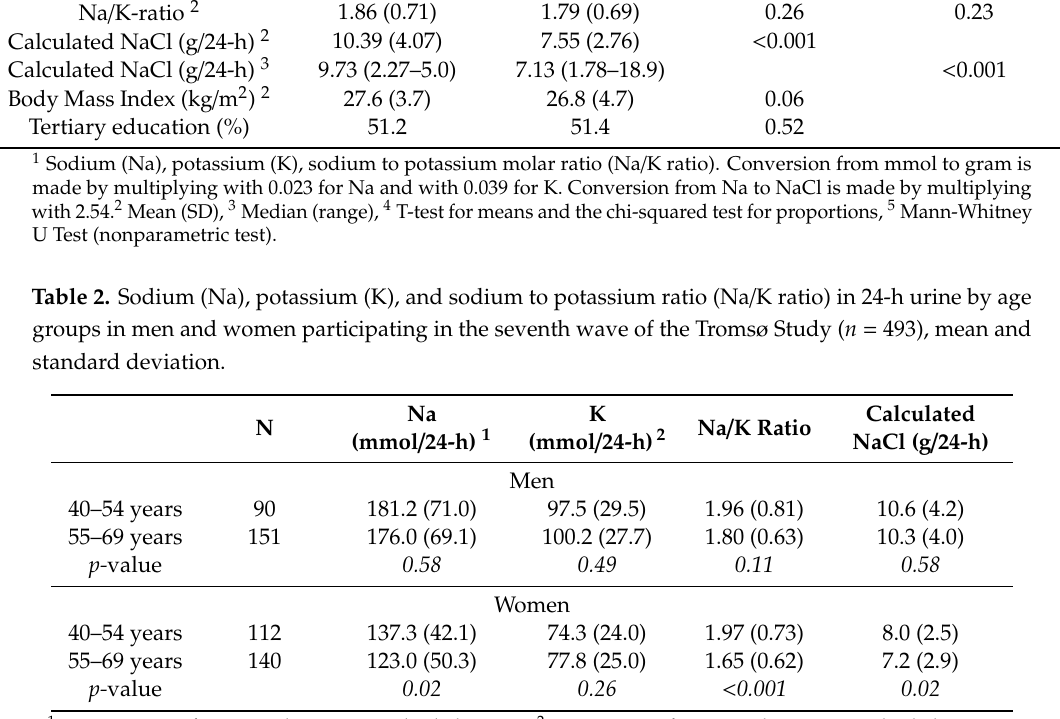
Table 3. Mean sodium (Na), potassium (K), and sodium to potassium ratio (Na / K ratio) by